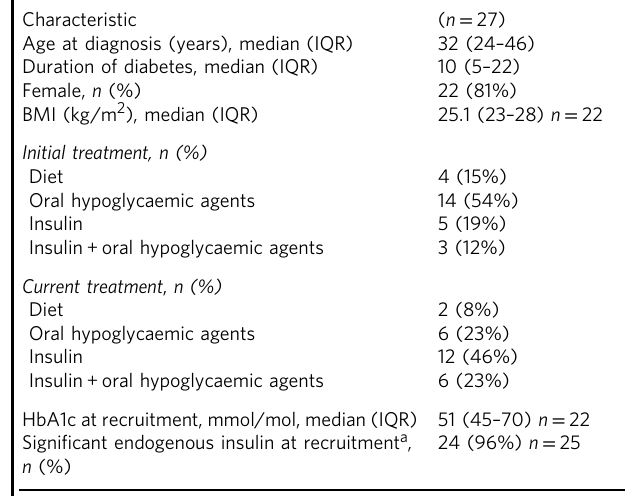
Fig. 2 Penetrance of diabetes in people with MODY. Heterozygous RFX6 PTV ( n = 18), pathogenic HNF1A variant ( n = 1265) or HNF4A variant ( n =